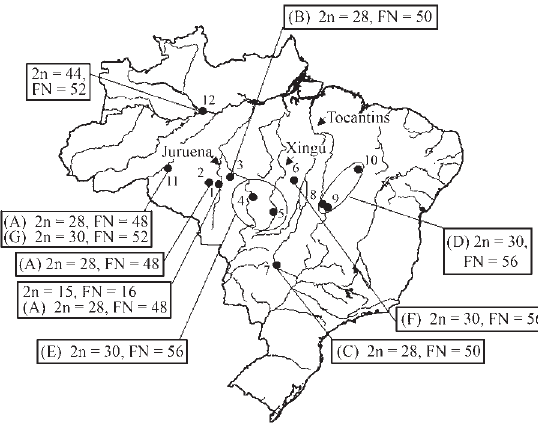
Figure 1 - Collection localities in Brazil and diploid and fundamental numbers of Proechimys specimens (numbers indicate locality records): 1, 2,3,6,11and12:locatedintheAmazonianrainforestbiome;4-5:located in transitional areas between Amazonian rainforest and Cerrado biomes; 7-10: located in the Cerrado biome. (1) Juruena; (2) Aripuanã; (3) Apiacás; (4) Cláudia; (5) Gaúcha do Norte; (6) Vila Rica, Mato Grosso state;(7)ParqueNacionaldasEmas(PNE),Goiásstate;(8)Paranãand(9) Peixe,Tocantinsstate;(10)EstaçãoEcológicadeUruçuí-Una,Piauístate; (11) Usina Hidrelétrica Samuel, Jamari River, Rondônia state; and (12) Manaus, Amazonas state. Capital letters (A-G) represent different karyomorphs of 2n = 28 and 2n = 30. The rivers (Xingu, Tocantins and Juruena) are also